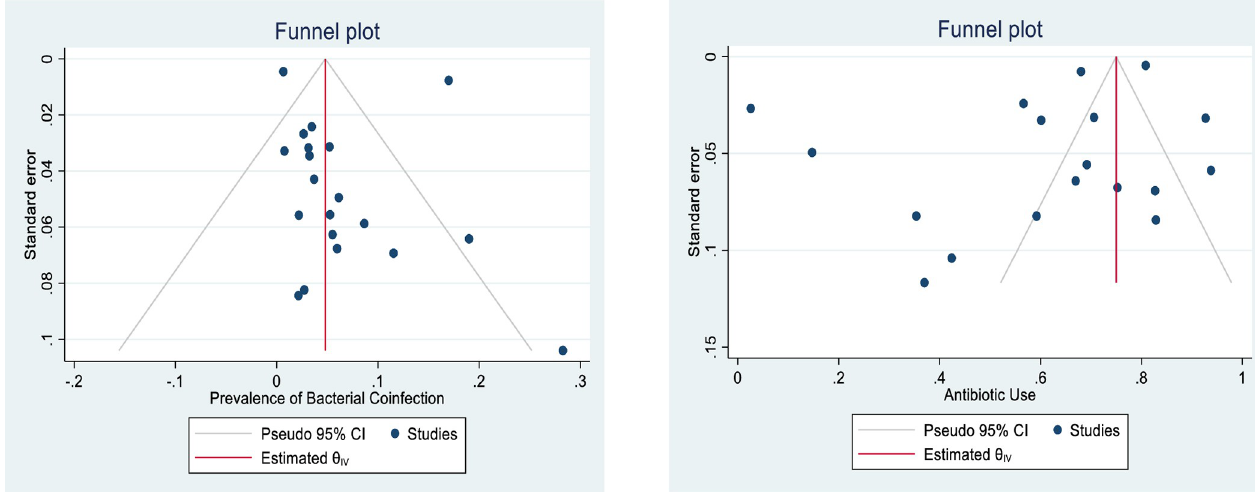
Fig 8. Funnel plots illustrating the assessment of publication bias for each primary